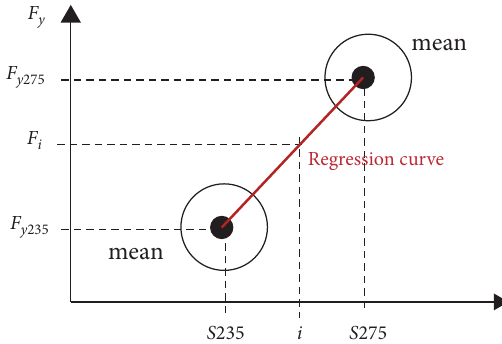
Figure 1: Mean and regression curves adjust applied.